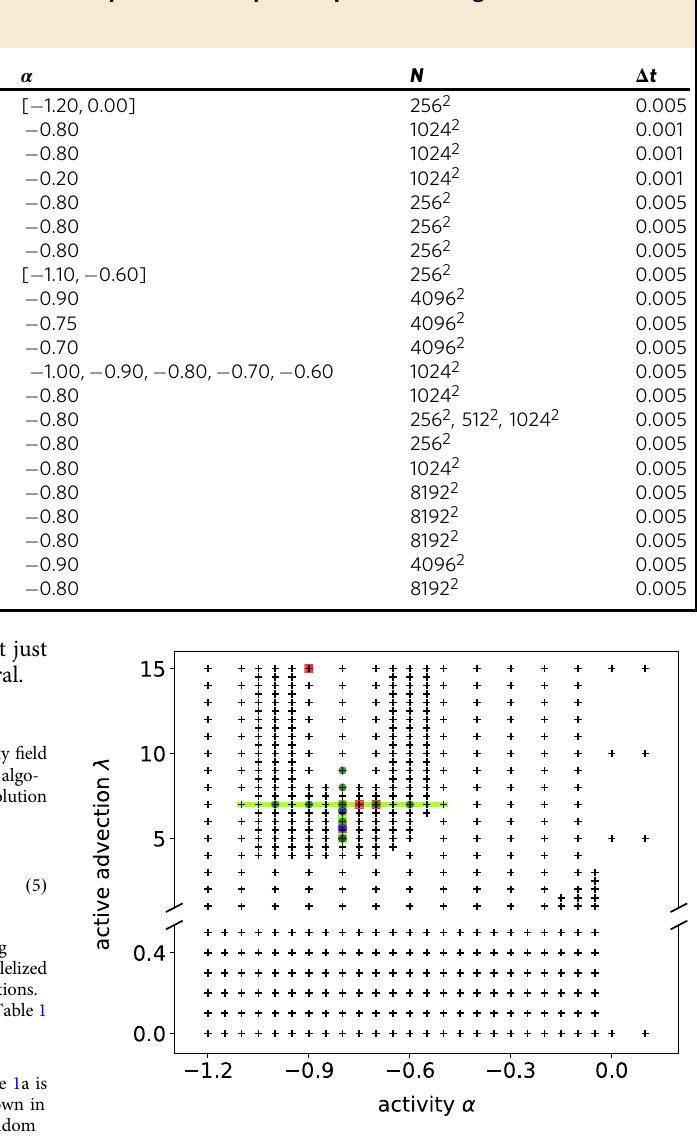
Fig. 6 Overview of simulation parameters. The crosses show the parameter con fi gurations used to obtain the phase diagram (Fig. 1, domain size L = 20 π ). Each cross represents simulations with two different initial conditions, as noted in the text. The PDFs in Fig. 1f are based on simulations with parameters marked with blue circles ( L = 20 π ). The phase transition curves Fig. 1g and h are based on simulations with parameters marked with a light green line ( L = 20 π ). The parameters used in Fig. 2 are indicated by red squares ( L = 1000 π ) and the parameters used in Fig. 3 by dark green circles ( L = 200 π ). Figures 4 ( L = 10 π − 160 π ) and 5a ( L = 1000 π ) are based on the parameter choice shown in yellow. Figures 5b ( L = 1000 π ) and 1e ( L = 20 π ) are based on the parameter choice indicated by a pink square. See also Table 1 for the parameter